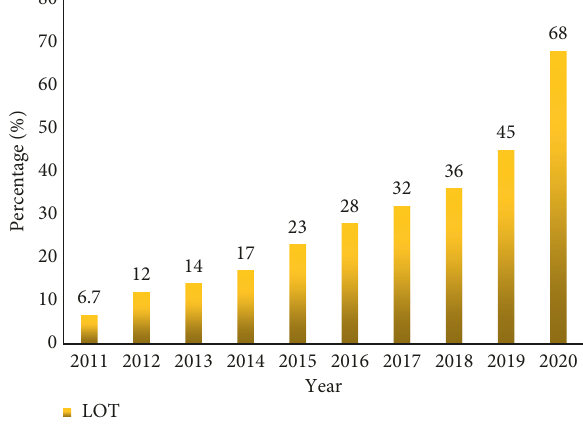
Figure 3: Development of IoT